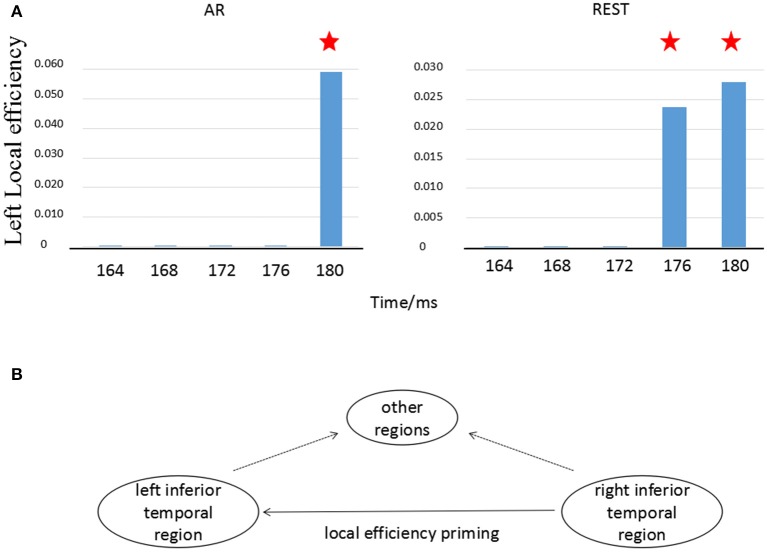
Local efficiency in left temporal-parietal region changes with time. (A) Local efficiency changes in left temporal-parietal region over time, (B) Illustration of information transfer on local efficiency. The blue bar denotes the transformation of local efficiency in the left temporal-parietal region. The red asterisk (?) represents that there exists an information flow from right temporal-parietal region to left temporal-parietal region.